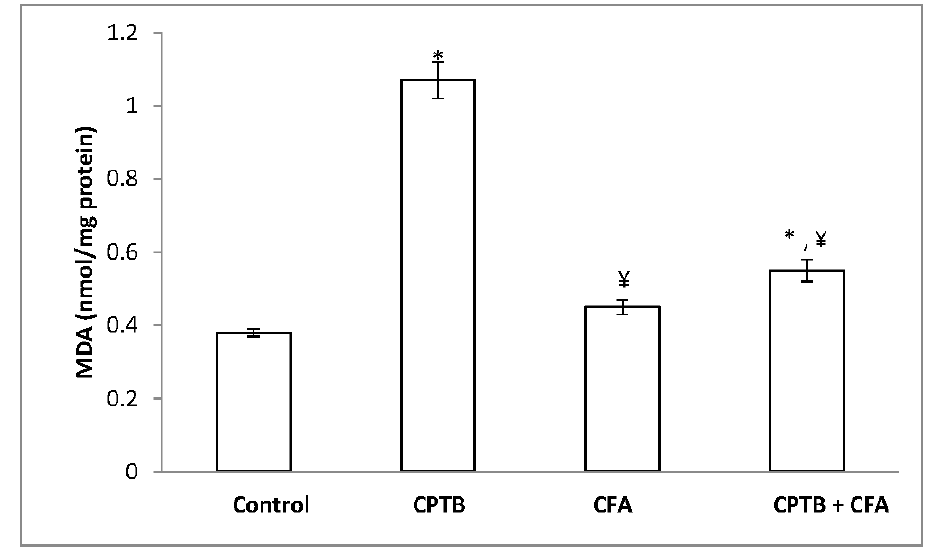
Figure 6. Protective effect of caffeic acid on the increase in lipid peroxidation (MDA) levels in rats due to capecitabine-induced toxicity. Data are expressed as means ± SD for six rats in each group; * significantly different from the control group ( p < 0.05); ¥ significantly different from the capecitabine group ( p < 0.05).